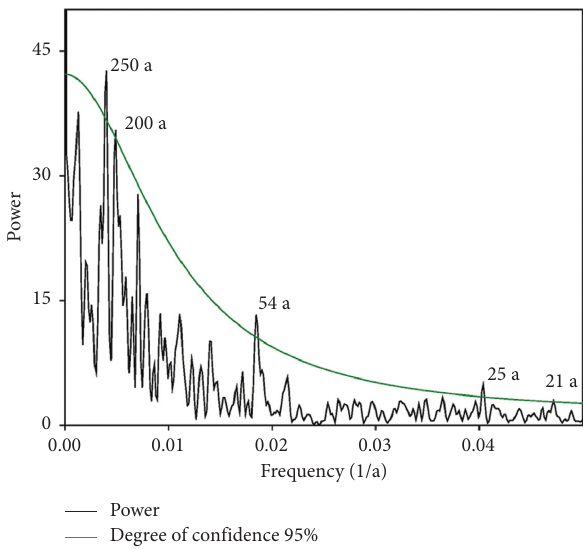
Figure 4: Spectrum analysis of stalagmite ND3 δ 18 O sequence by